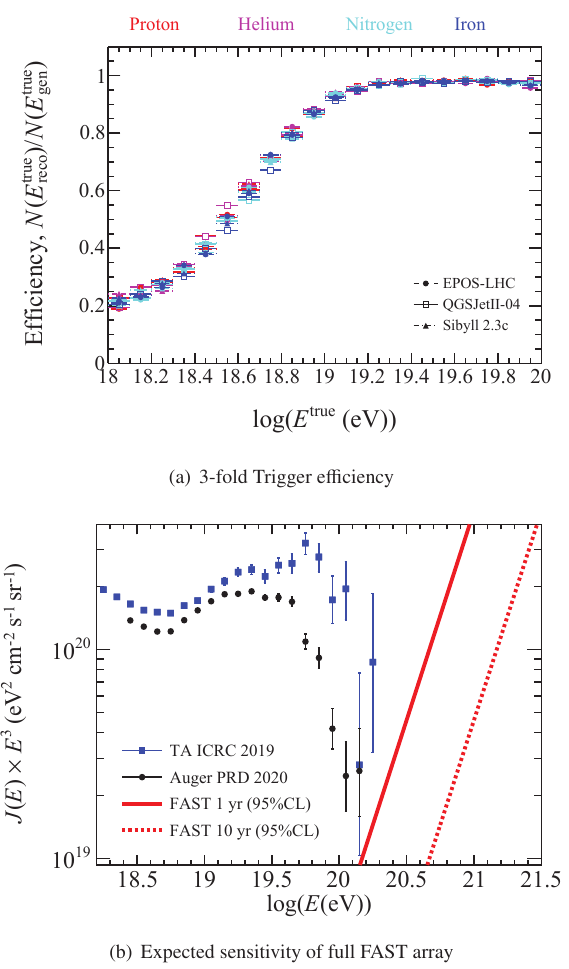
Figure 4. (a) Trigger e ffi ciency for 3-fold detections with a hy- pothetical FAST array. (b) Expected 95% confidence level de- tectable sensitivities of the energy spectrum with the full FAST array of 500 stations compared to the spectra reported from TA [15] and Auger [16].